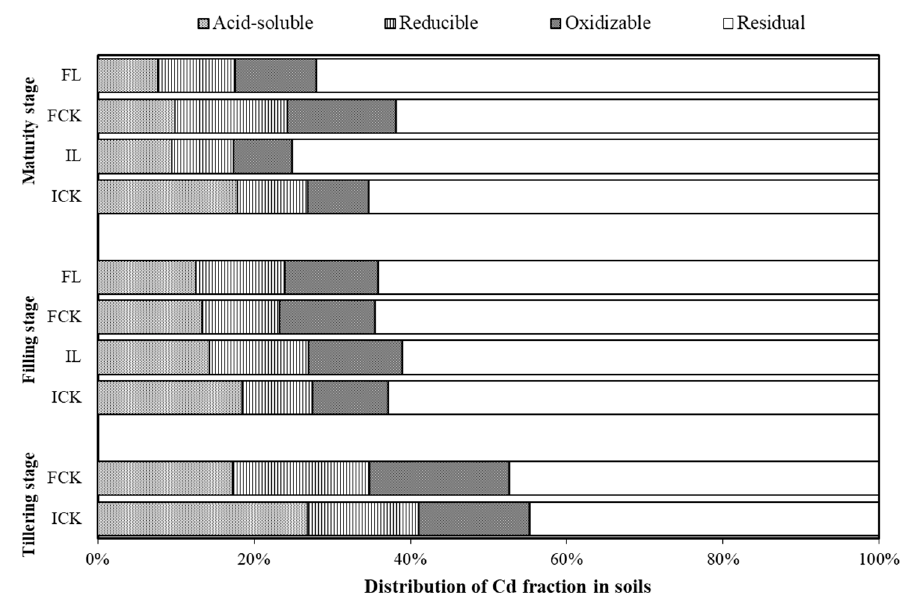
Figure 2. Percentages of Cd fractions in soil at different growth stages of rice. ICK, IL, FCK, and FL are